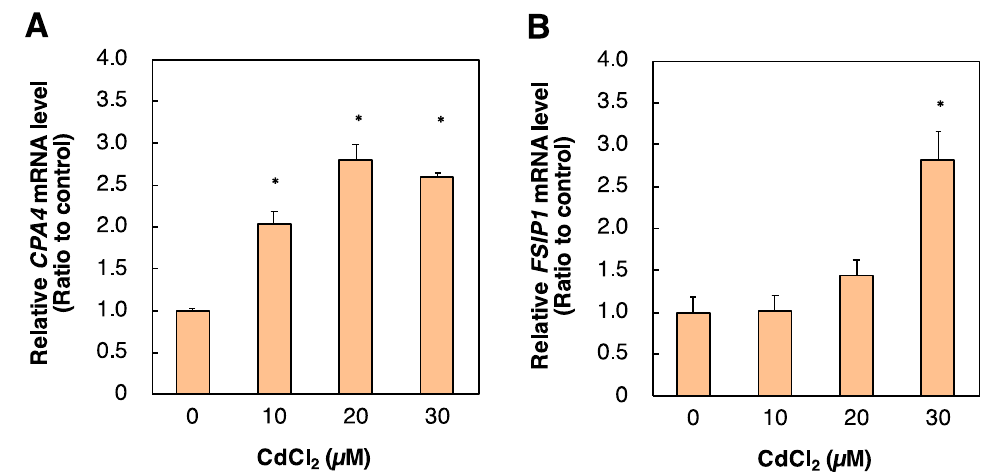
Figure 5. Effect of Cd on CPA4 and FSIP1 mRNA levels in HK-2 cells. HK-2 cells were treated with Cd for 6 h. CPA4 and FSIP1 mRNA levels were examined by real-time RT–PCR after Cd treatment for 6 h ( A , B ). CPA4 and FSIP1 mRNA levels were normalized to GAPDH mRNA levels. Values are means ± SD ( n = 3). * Significantly different from the control group, p < 0.05. Table 1. Genes with expression increased by PPARD knockdown (> 3-fold).